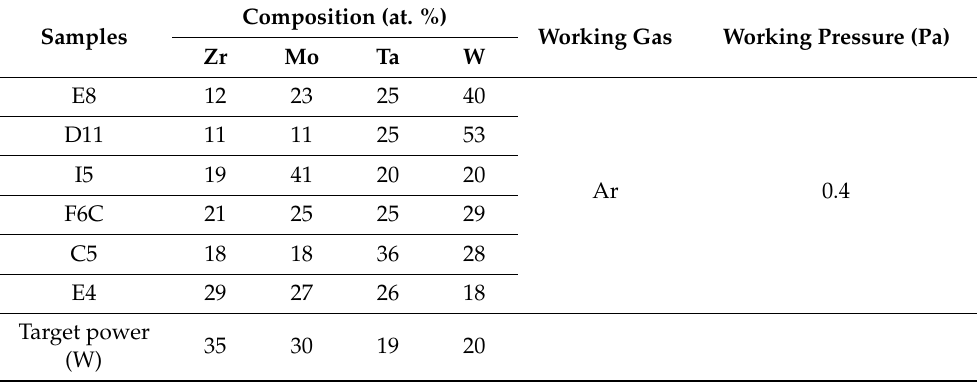
Table 1. Experimental parameters of the ZrMoTaW RMPA films. Composition (at. Samples